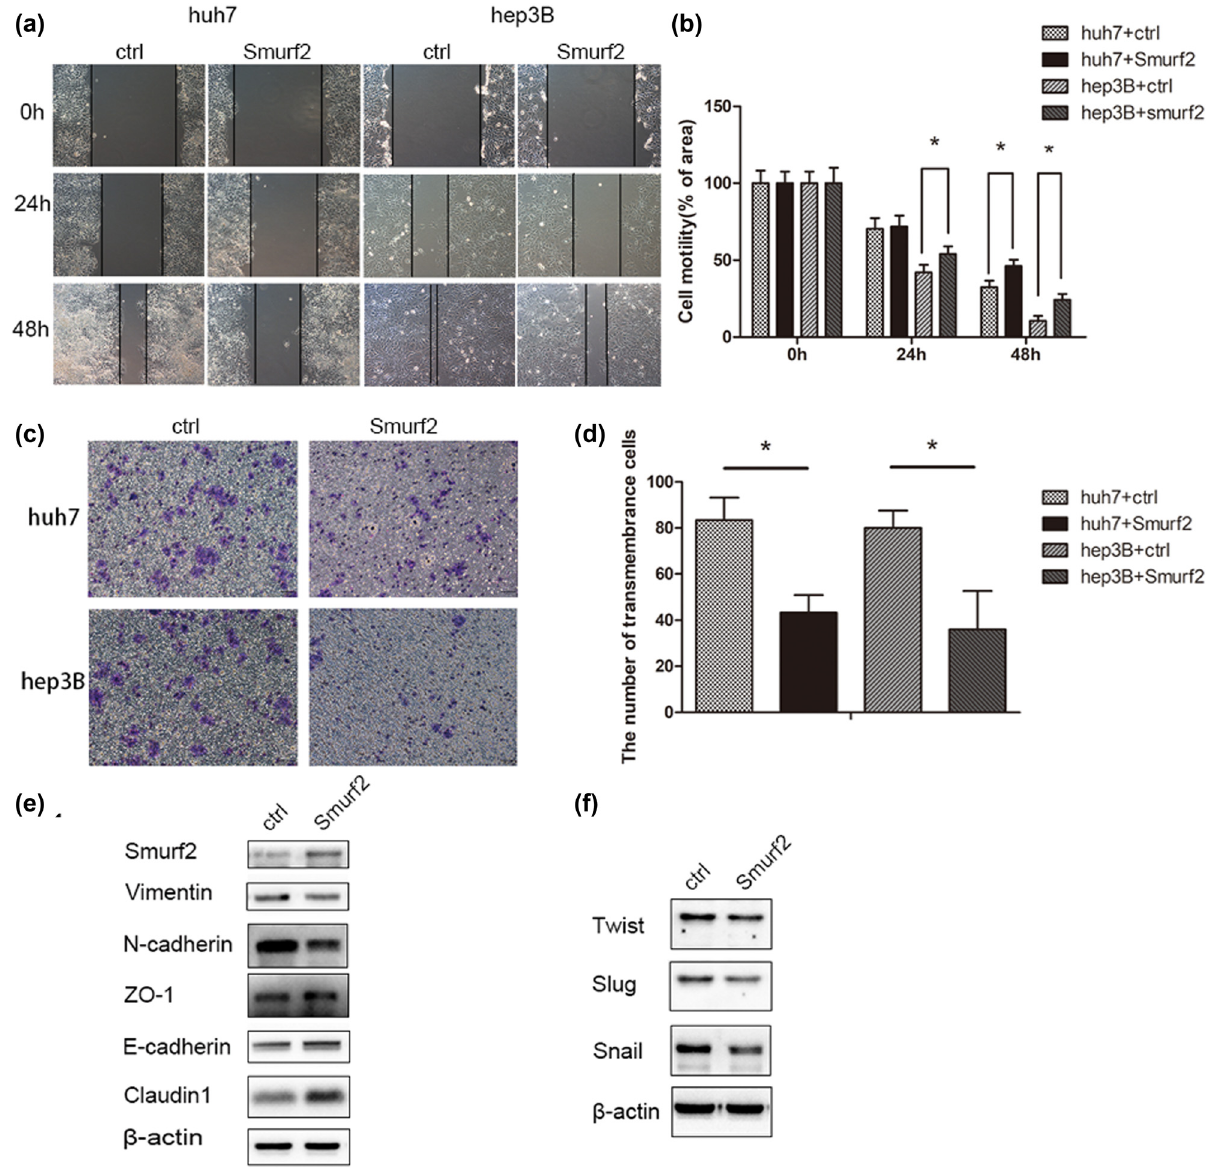
Figure 2: Smurf2 suppressed the migration of human HCC cell lines. ( a and b ) Wound healing assay in Hep3B - Smurf2 and Huh7 - Smurf2 cells, * P < 0.05; ( c and d ) transwell migration assay of Hep3B - Smurf2 and Huh7 - Smurf2 cells, * P < 0.05; ( e ) the immunoblotting of E - cadherin, ZO - 1, Claudin - 1, N - cadherin, and Vimentin protein levels in Huh7 - Smurf2 cells; ( f ) the immunoblotting of EMT transcription factors protein levels in Huh7 - Smurf2